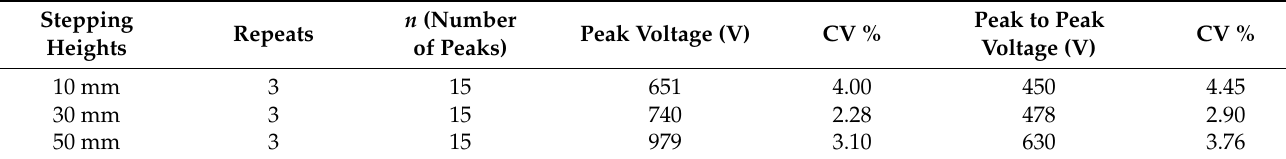
Table 4. Effect of stepping height on the electrostatic charge generation.